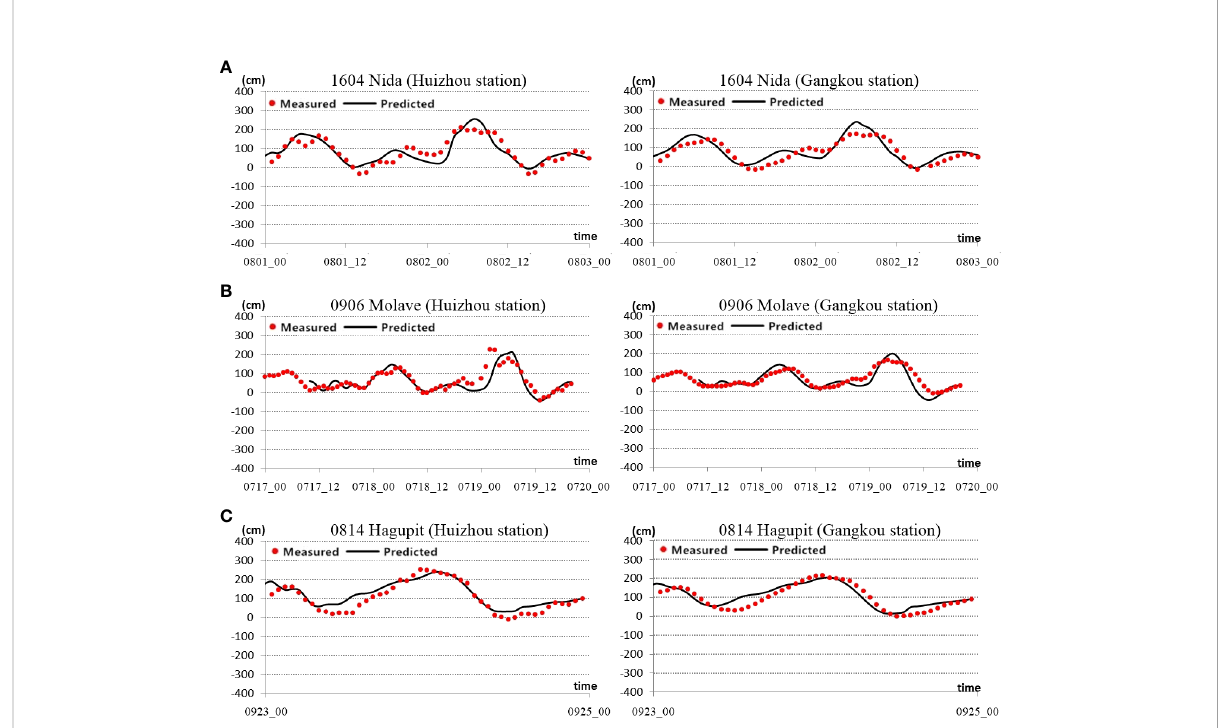
FIGURE 4 Time series of predicted total water elevations and actual water levels measured by tide gauge stations under the typhoon events (Hagupit (A) , Molave (B) , and Nida (C) .